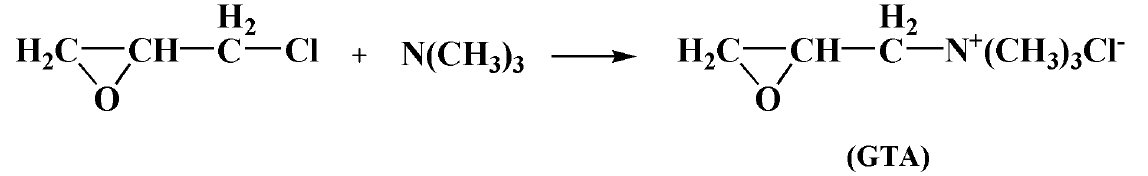
Figure 2. Reaction equation of GTA.